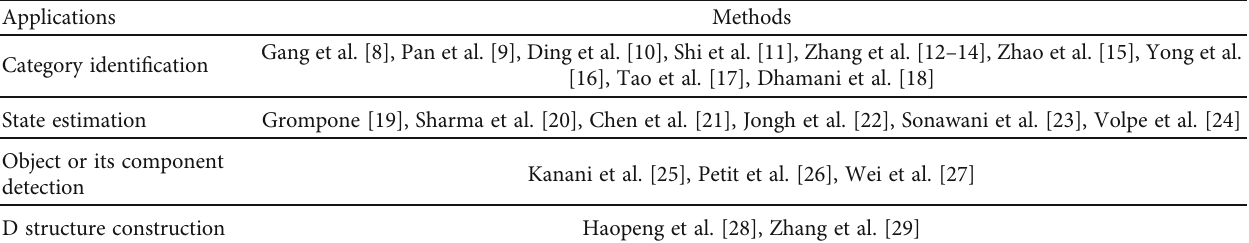
Table 1: Existing large space debris identi fi cation